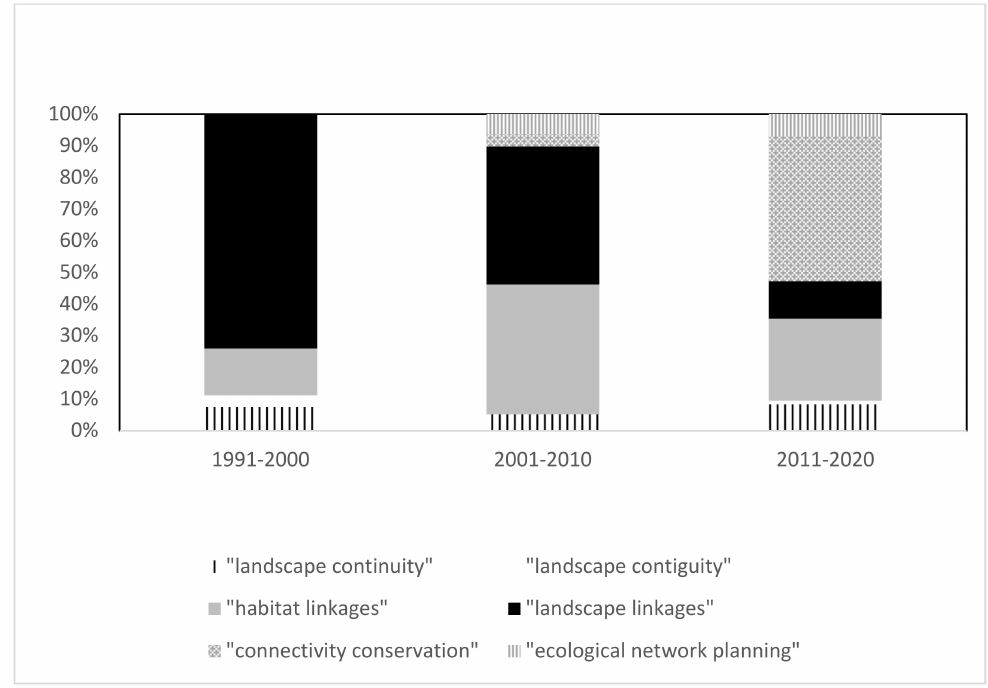
Figure 5. Percentage frequency of recurrence ( y -axis) for the secondary focal terms from 1991 to